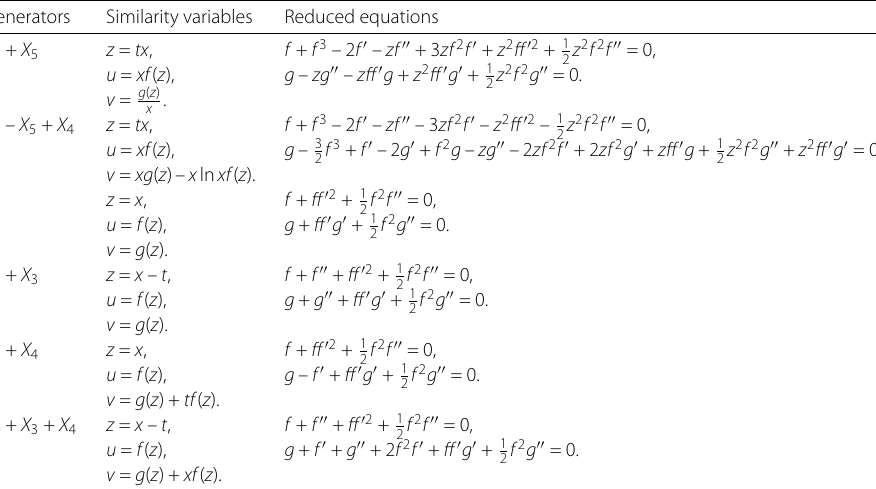
Table 2 Similarity reductions of the Yao–Zeng two-component short-pulse equation Generators Similarity variables Reduced equations X 1 + X